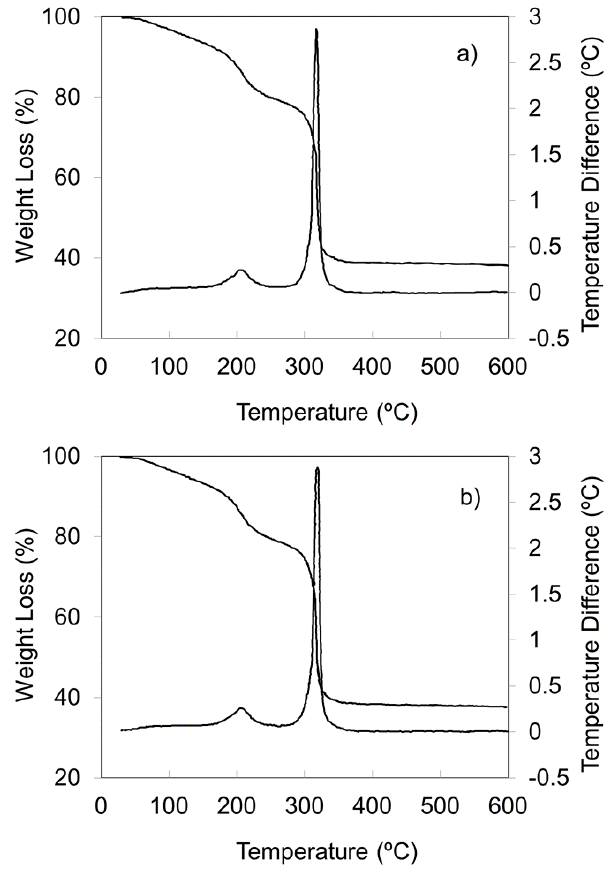
Figure 6. Thermogravimetric analysis (TGA) profiles for: ( a ) Cu / ZnO / Al 2 O 3 -OA oxalate, Cu / Zn / Al (molar) = 35 / 35 / 30; ( b ) Ni / Cu / ZnO / Al 2 O 3 -OA oxalate, Ni / Cu / Zn / Al (molar) = 5 / 32.5 / 32.5 /